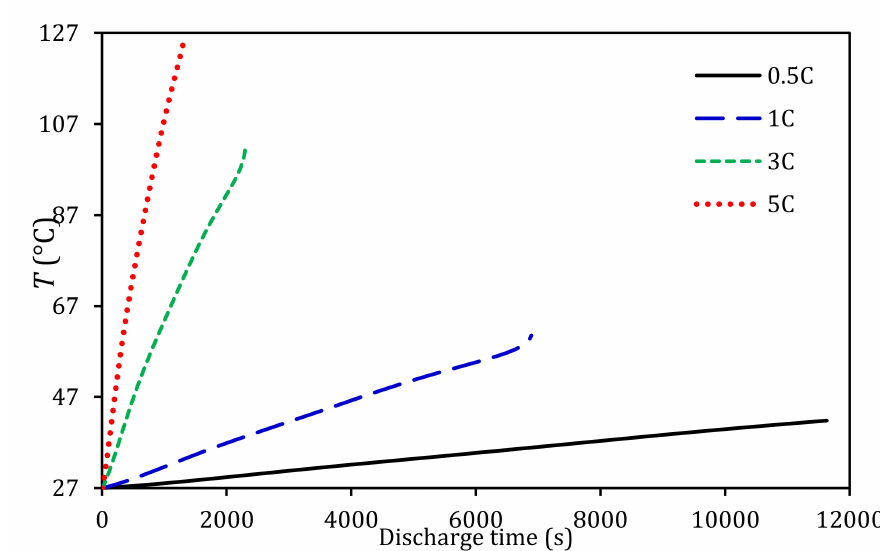
Figure 6. LIB module (3S2P) temperature during full depletion at different discharge rates.